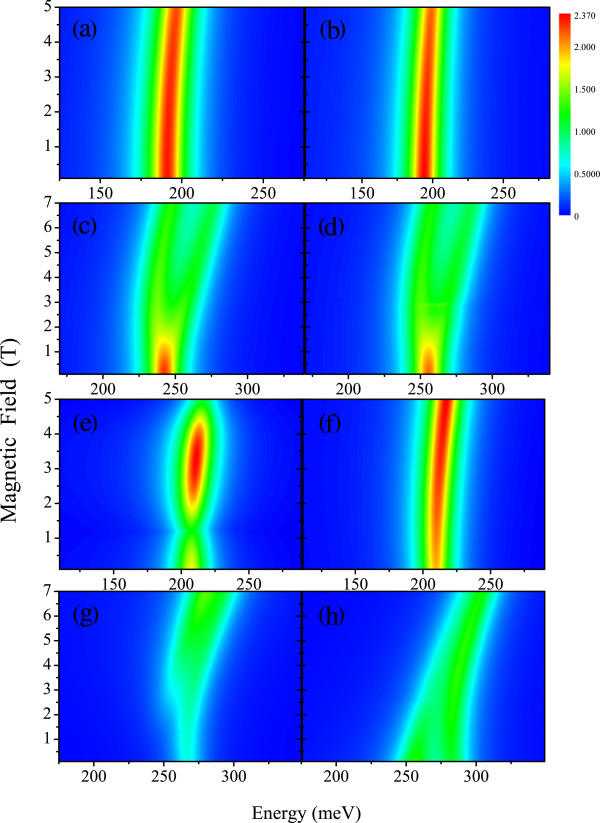
Interband absorption spectra as function of magnetic field for polarization Πz (a-d) and σ+ (e-h) Pb0.99Mn0.01Se NCs with spherical (a,e) and semispherical (b,f) confinements and Pb0.99Mn0.01Te NC with spherical (c,g) and semispherical (d,h) confinements. The same parameters were as referred in Figures
1 and
2.